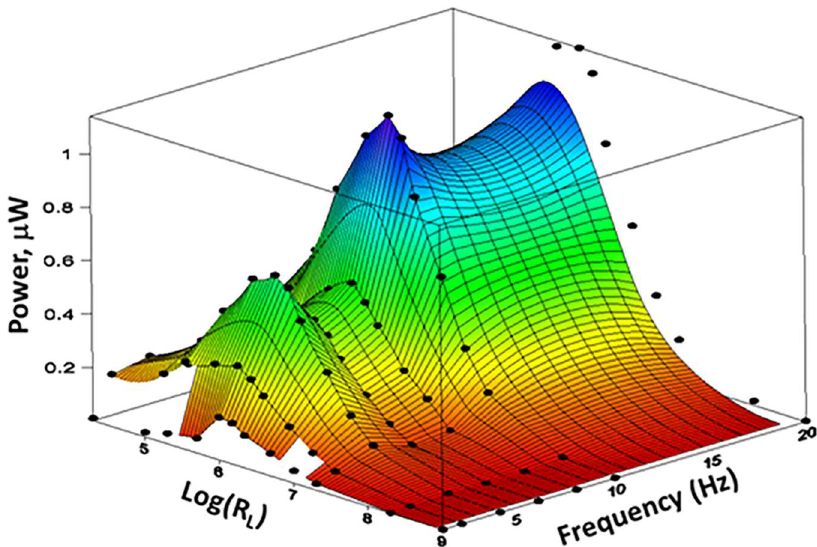
Fig 2. Effect of excitation frequency and load resistanceon power output from PVDF strip exposed to repetitive pulses of N 2 gas at 34 PSI. Optimal R L corresponds to capacitive reactance of piezo. Sweet spot appearsto exist at ~ 4 Hz, perhapsdue to